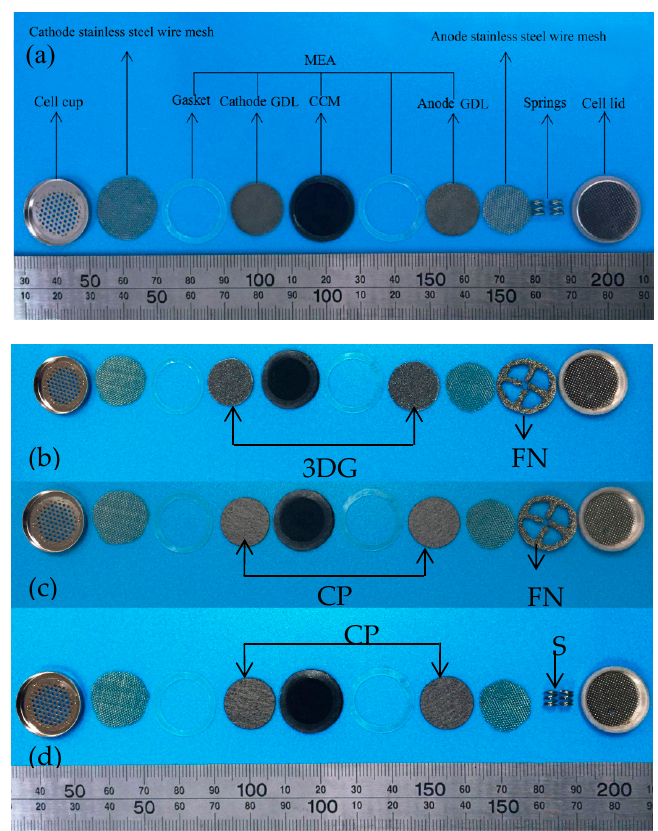
Figure 1. Photograph of the button-type micro direct methanol fuel cell(B- µ DMFC) components: ( a ) the three-dimensional graphene–springs (3DG + S) B- µ DMFC; ( b ) the 3D graphene–foam nickel